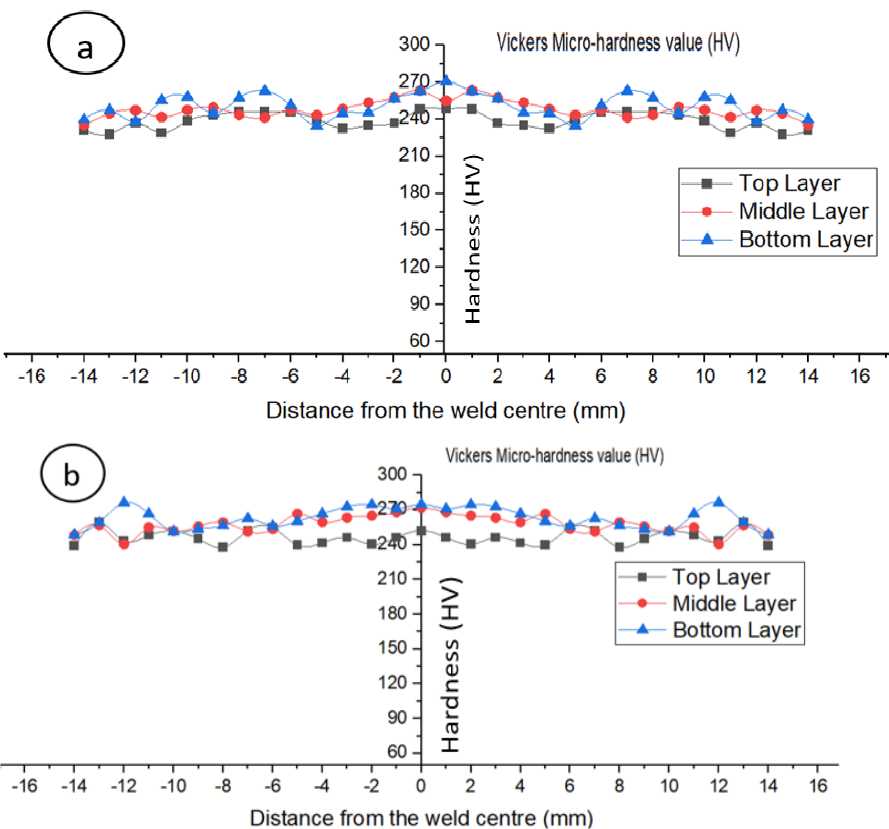
Figure 11. Microhardness profiles on joint cross-section; ( a ) trial 1, ( b ) trial 3.